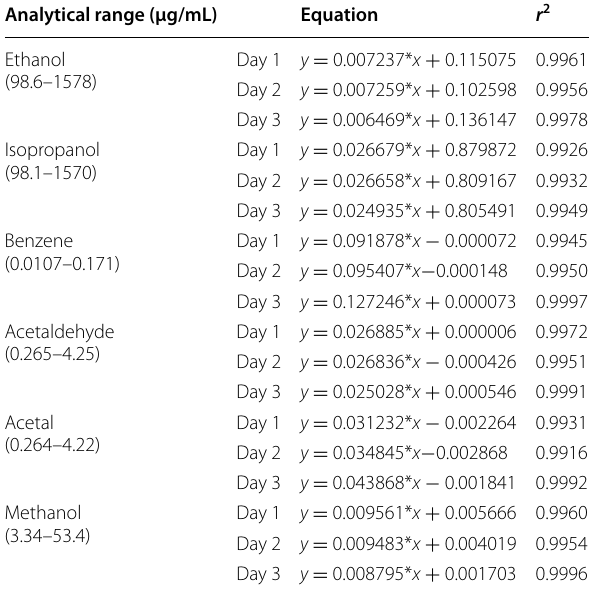
Table 3 Linearity and range